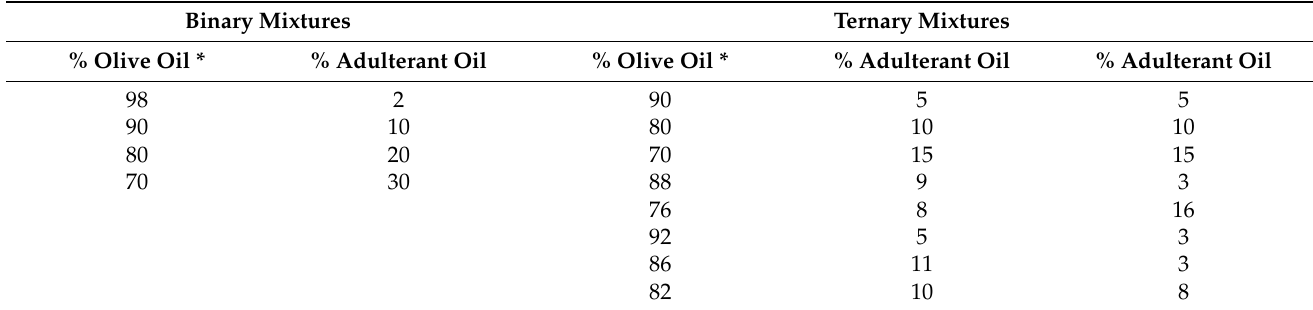
Table 1. Percentage distribution of binary (olive oil and one adulterant oil) and ternary (olive oil and two adulterant oils) mixtures.